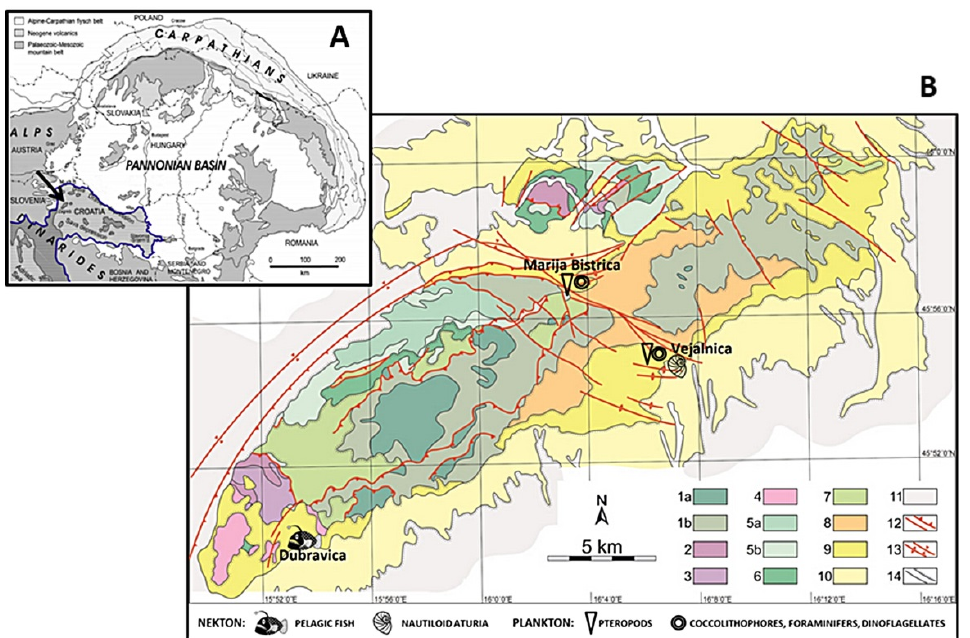
Figure 10. ( A ) Position of Mt. Medvednica near the SW shoreline of the Central Paratethys, marked by the black arrow (after [2]; from [65]). ( B ) Geological map of the Medvednica Mt. according to [113]; modified. Legend: 1a,b. Silurian to Middle Triassic metamorphic rocks; 2–4. Triassic clastic and carbonate sedimentary rocks; 5 a,b. Mesozoic ophiolites; 6. Aptian to Cenomanian marine sedimentary rocks; 7. Uppermost Cretaceous to Paleocene transgressive succession; 8. Early Miocene fluvial and lacustrine deposits; 9. Middle Miocene marine to brackish sedimentary rocks; 10. Late Miocene brackish and marsh deposits; 11. Pliocene clastic deposits; 12. Faults; 13. Fold axes; 14. Normal and transgressive boundaries.